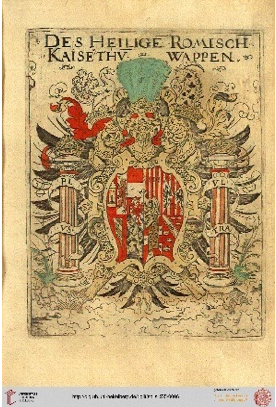
Figure 6. CoA of the Holy Roman Empire.